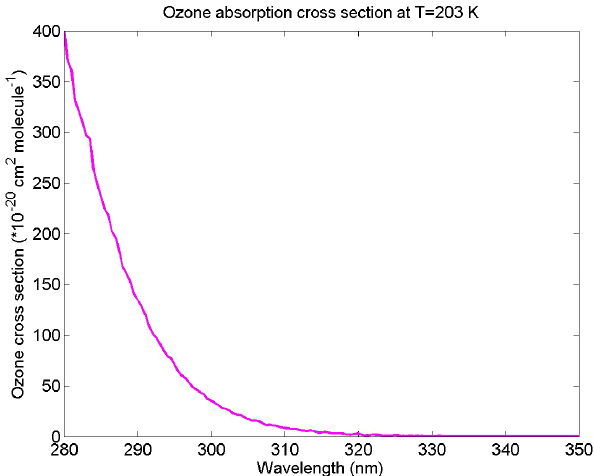
Figure 1. Ozone cross sections at 203K as a function of the wave- length.